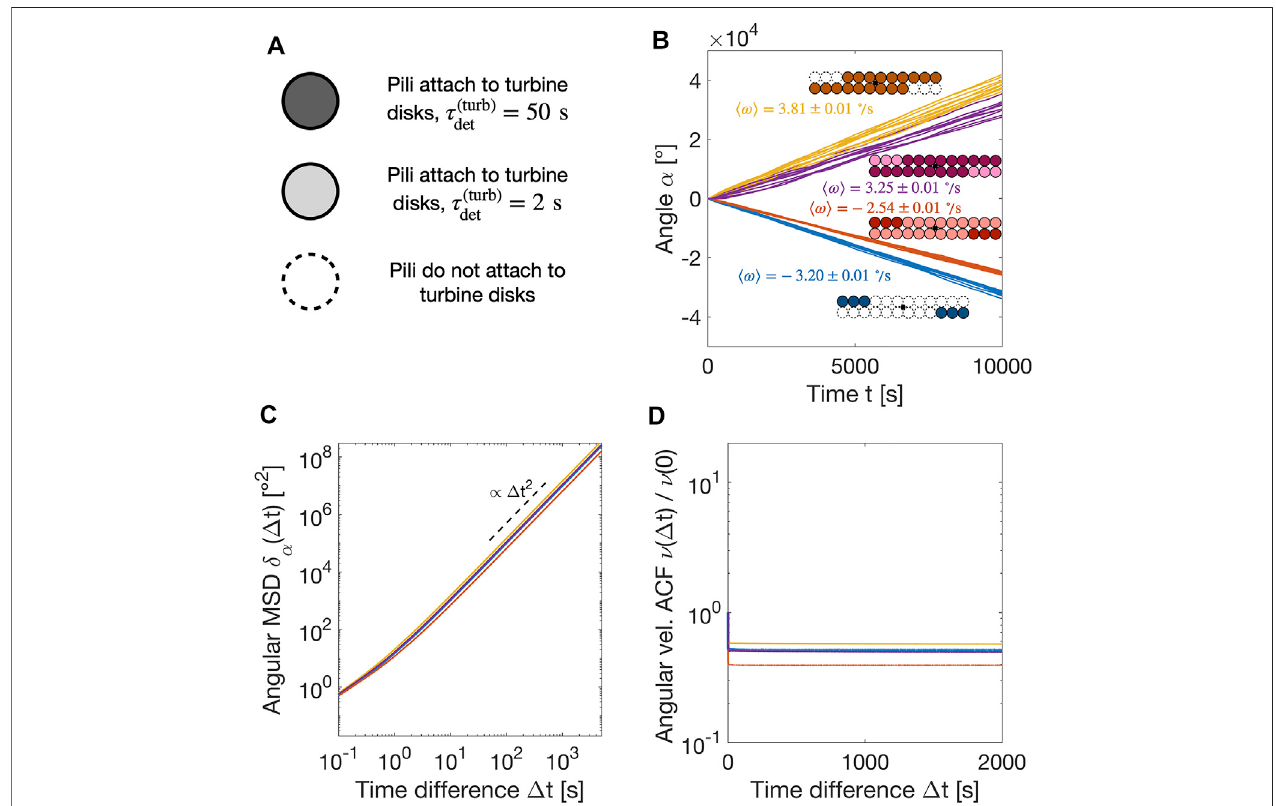
FIGURE 5 | Unidirectional persistent turbine rotation is caused by asymmetric pili binding to the turbine. (A) Overview of the different types of turbine disks consideredhere. (B) Angle α oftheturbineasafunctionoftime t fordifferentcombinationsofthemanipulatedturbinedisks.Wealsoprovidetheaverageangularvelocity 〈 ω 〉 and its standard error for each condition. (C) The angular mean squared displacement exhibits superdiffusive (ballistic) scaling, δ α ∝ Δ t 2 . (D) The normalised angular velocity auto correlation function is no longer decaying with increasing time differences Δ t , corresponding to the unidirectional rotation.